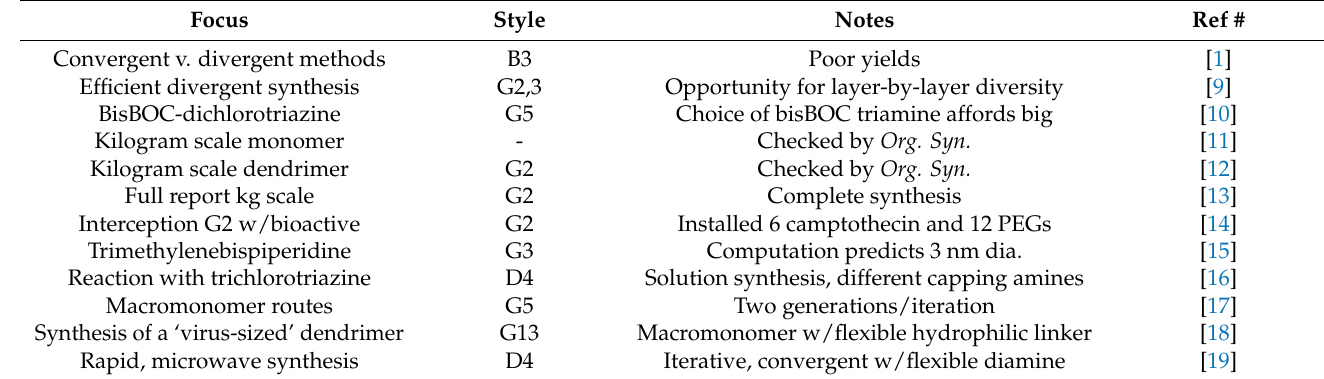
Table 2. Synthetic efforts using the divergent